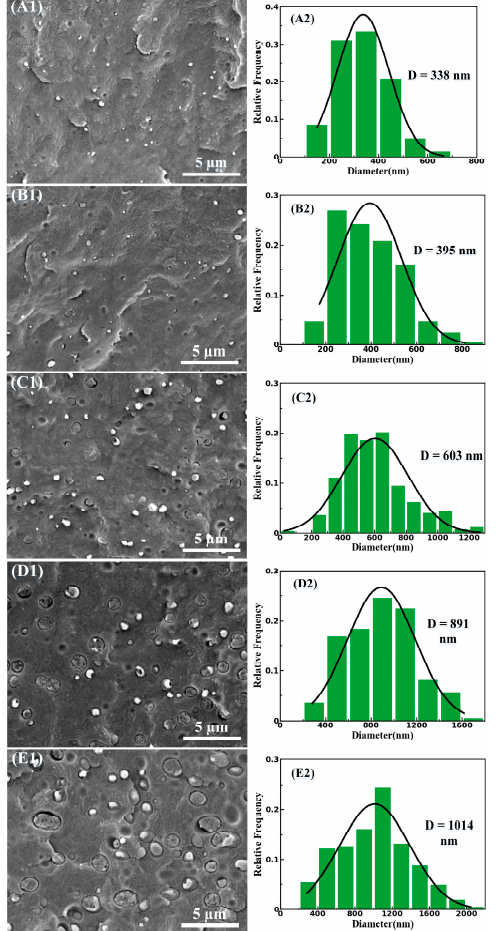
Figure 2. SEM micrographs of the cryo-fractured surfaces of the as-extruded PBS/PLA composites with 3 wt % (A1), 5 wt % (B1), 10 wt % (C1), 15 wt % (D1), and 20 wt % (E1) of PLA. The statistical with 3 wt % ( A1 ), 5 wt % ( B1 ), 10 wt % ( C1 ), 15 wt % ( D1 ), and 20 wt % ( E1 ) of PLA. The